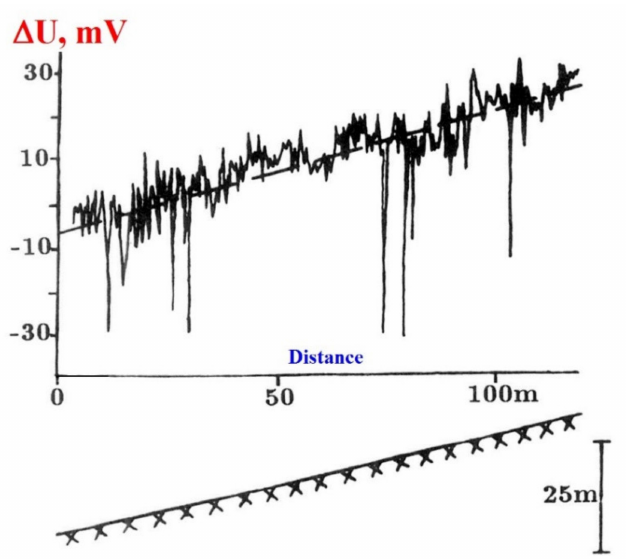
Figure 2. SP observations at inclined relief (after [39], with small modifications) (Middle Keuper of the Steigerwald highlands, 60 km east of Würzburg,